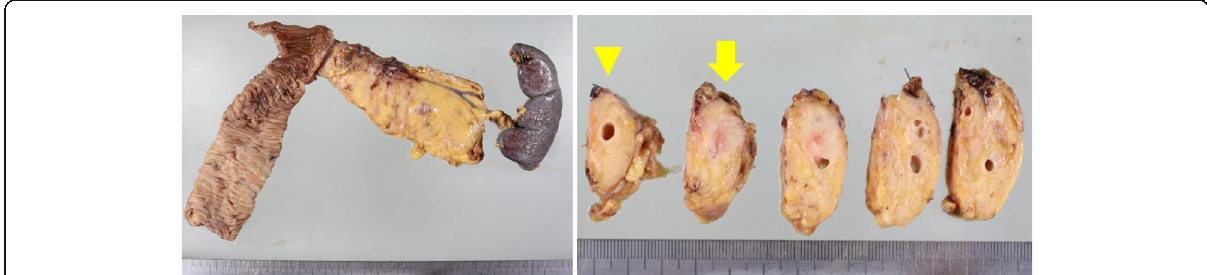
Fig. 6 Macroscopic appearance of the resected specimens shows an irregular white tumor (arrow) which is located at the distal side of pancreaticojejunal anastomosis (arrow